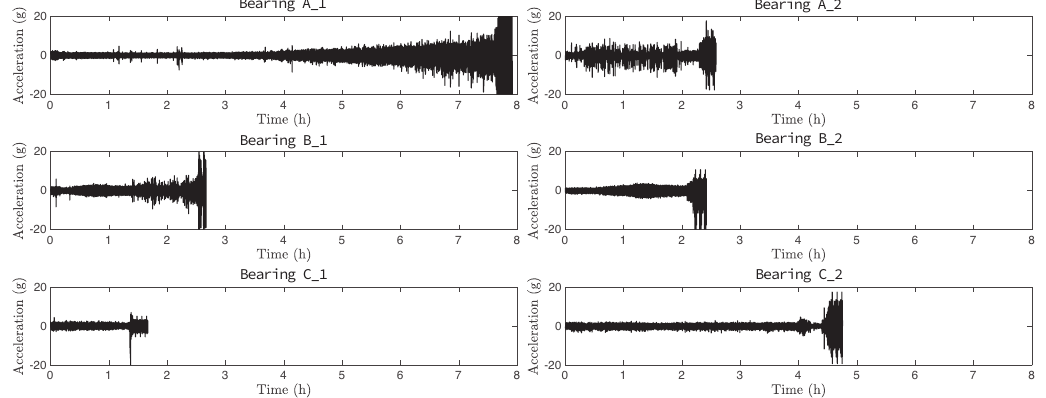
Figure 2. Horizontal vibration raw signal of training cases Bearing A _ 1 , Bearing A _ 2 , Bearing B _ 1 , Bearing B _ 2 , Bearing C _ 1 , and Bearing C _ 2